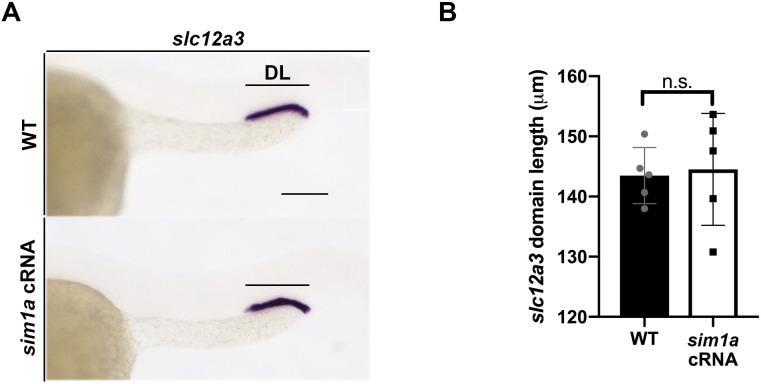
sim1a overexpression does not affect DL segment development.(A) WISH for slc12a3 (DL) in WT (top) and sim1a cRNA injected 28 ss zebrafish embryos. Scale bar = 100 μm. (B) Graph indicating the slc12a3 domain length in WT compared to sim1a cRNA overexpression. Data are represented as ±SD, and were not significant by t test, n.s. = not significant.